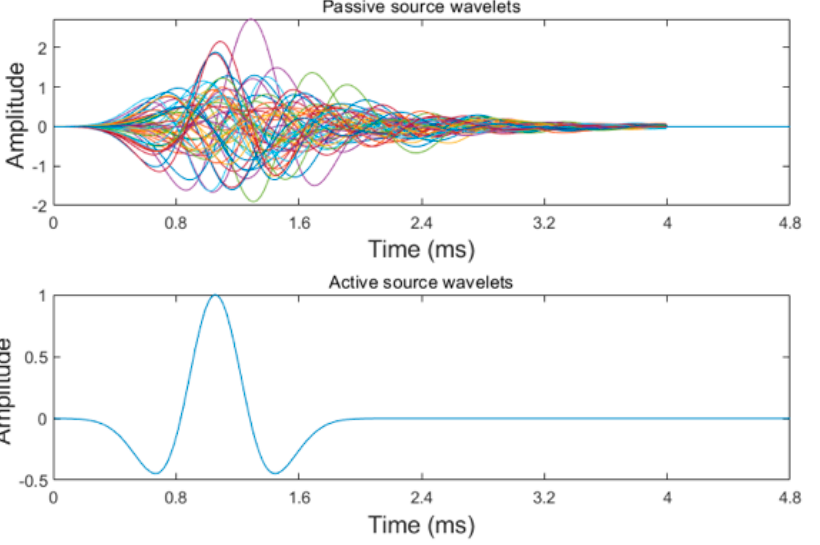
Figure 7. The true source wavelets for the passive datasets and the different color lines means different source wavelets ( upper figure ), and active dataset ( lower figure ).